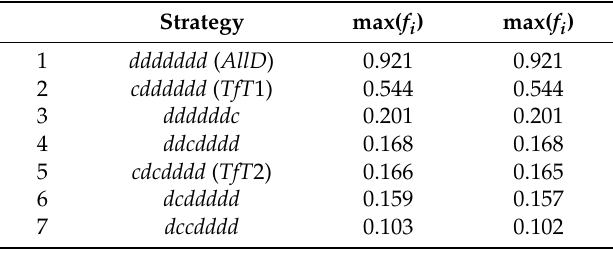
Table 4. List of strategies that obtain peak frequencies higher than 0.1 (max( f i ) > 0.1) within the cycle phases of the dgm -dynamics depicted in Figure 1b. Code representation (conventional name in brackets) of the strategies is given in the second column. The peak frequency within the cycle phases is given in the third column. The peak frequency within the cycle phases of the cgm -dynamics of Figure 1c is given in the fourth column.